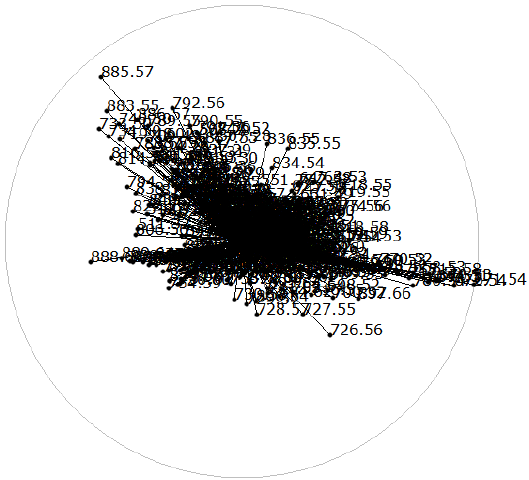
Figure 7. Star coordinates (SCs) of linear embedding in Figure 6 reveals which dimensions were given more weight to separate clusters in the form of long dimension axis